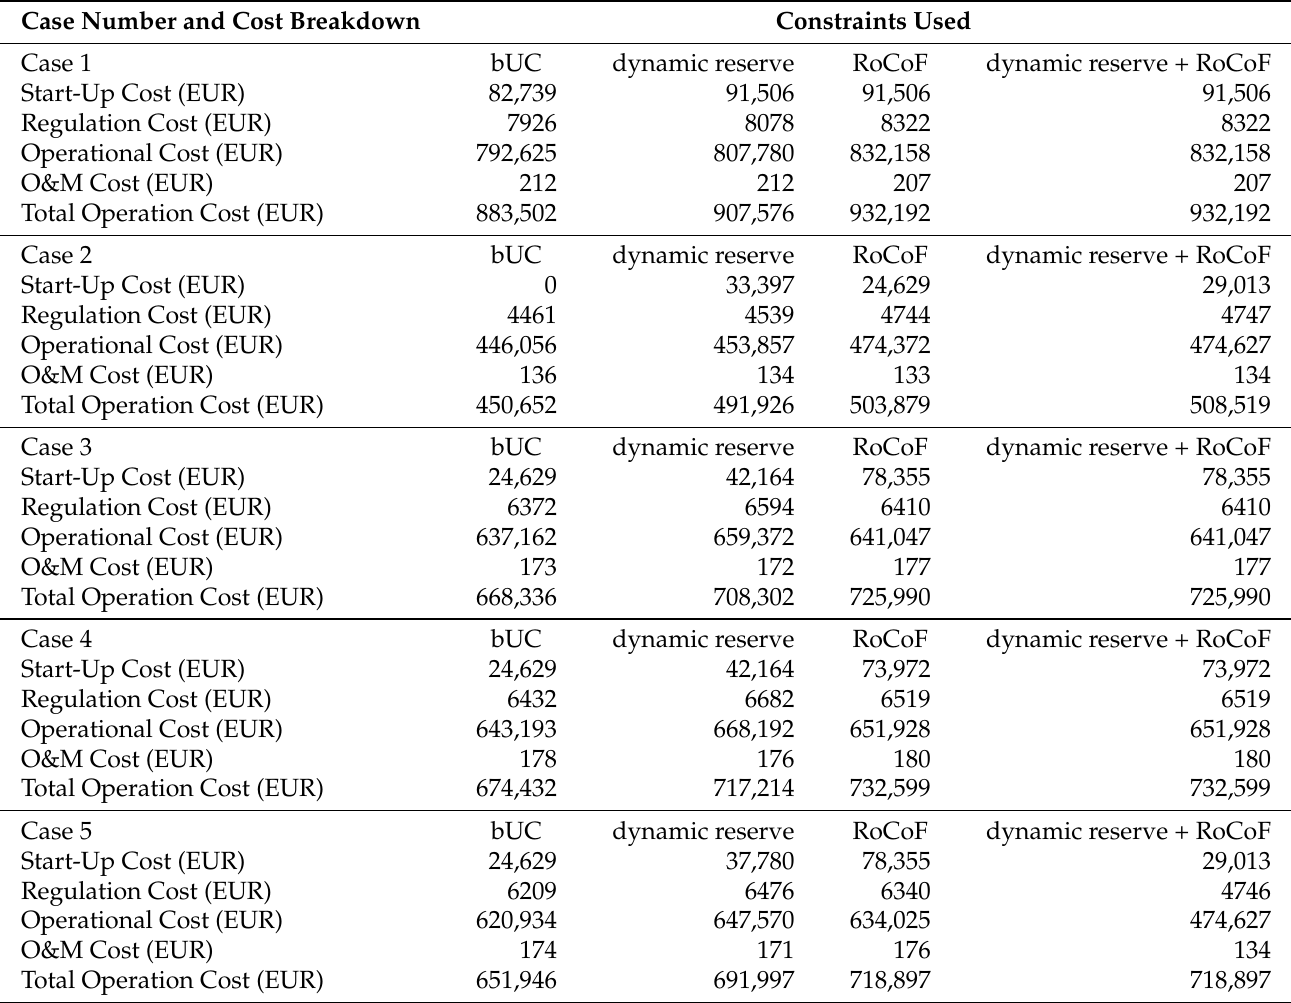
Table 5. Total operational cost breakdown for the five cases and the three ways of constraint use.